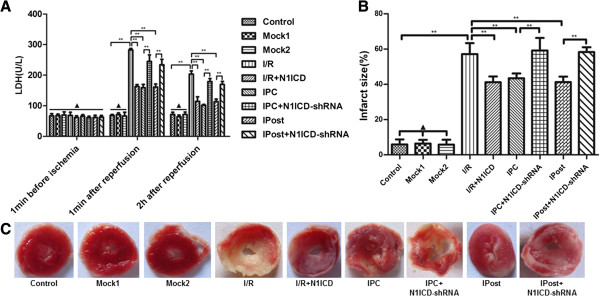
Notch1 signaling inhibits LDH release and reduces infarct size in isolated rat hearts. A, LDH release in each group. B, infarct size in each group. C, TTC staining of cardiac slices in each group. Data were presented as mean±SD, n=6. Mock1 indicated the hearts infected with empty vector, Mock2 indicated the hearts infected with vector containing nonspecfic sequences. ▲P>0.05, *P<0.05, **P<0.01.